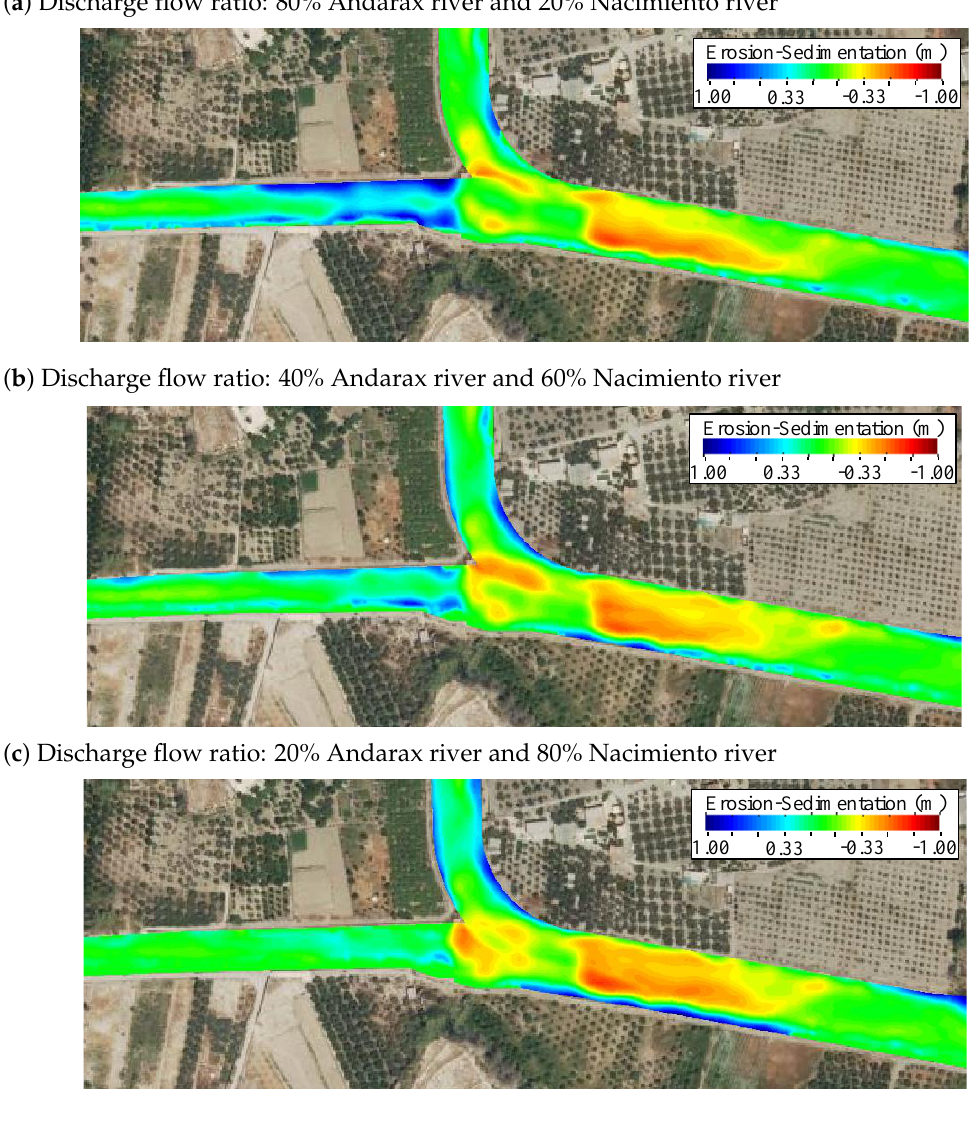
Figure 11. Effect of the discharge ratio on the erosion patterns. Here we plot the erosion patterns under the 10-year flood event. In panel ( a ) the total flow distributes 80% in the Andarax river and 20% in the Nacimiento river, in panel ( b ) the distribution is 40% in the Andarax river and 60% in the Nacimiento river, and in panel ( c ) it is 20% in the Andarax river and 80% in the Nacimiento